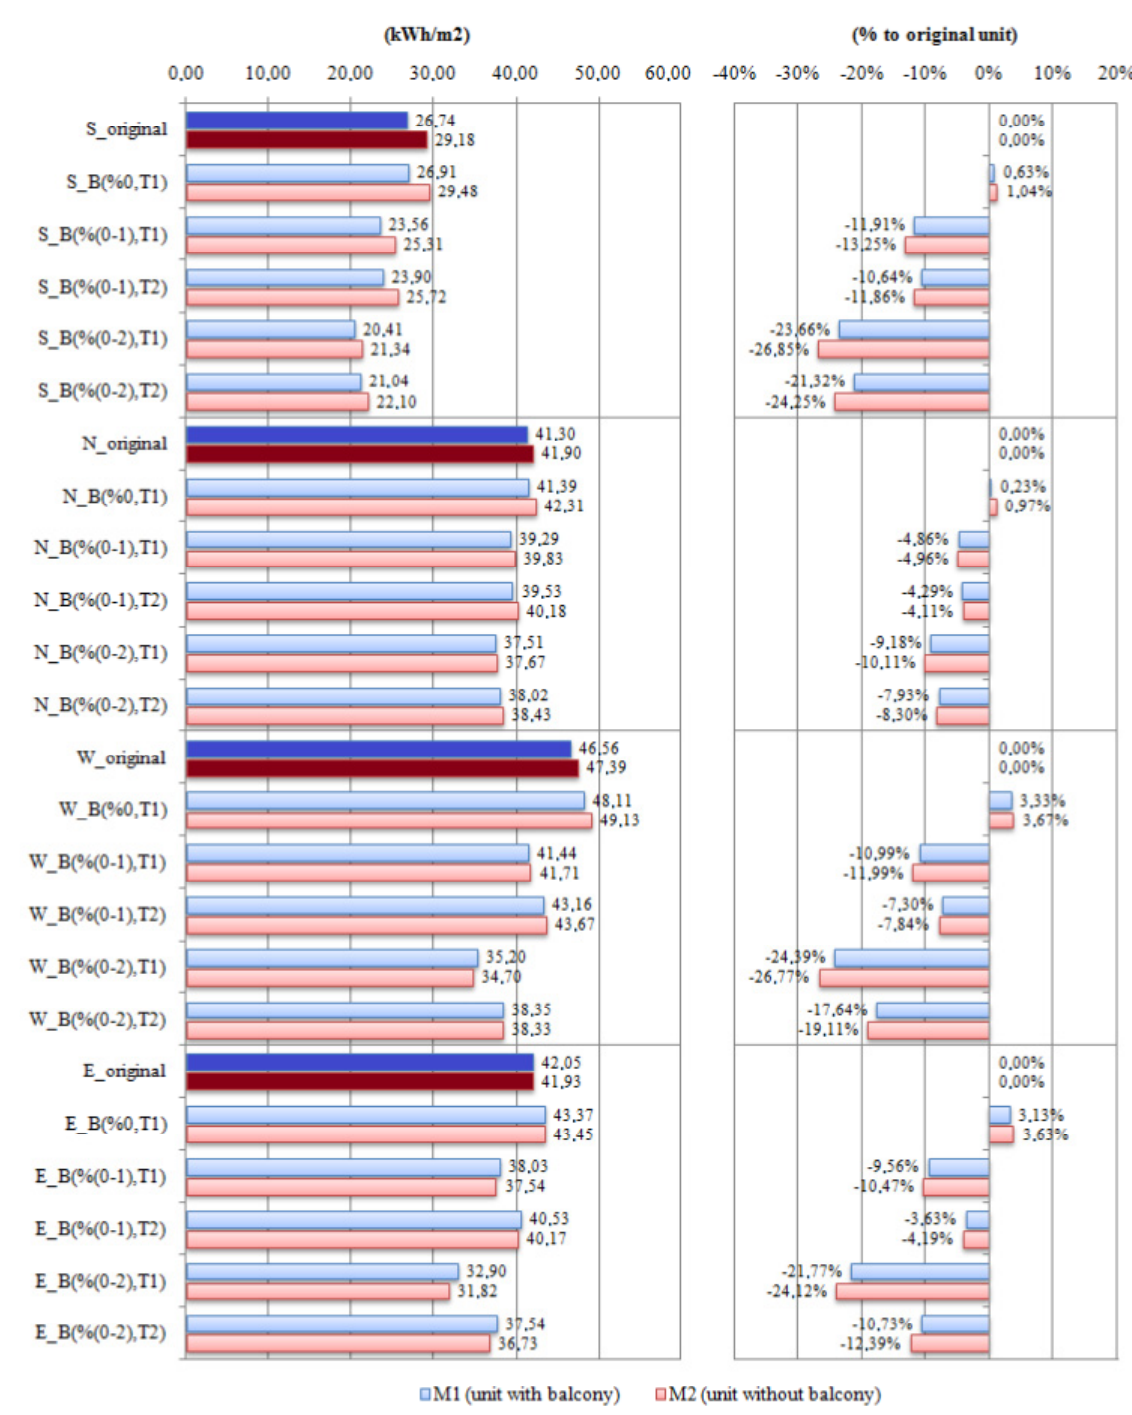
Figure A6. B Series: Annual thermal